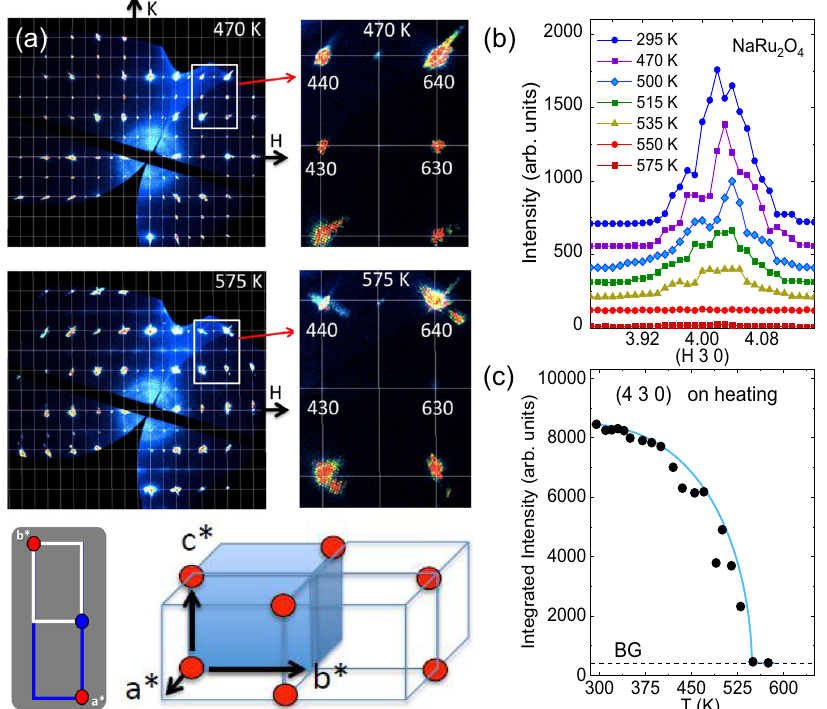
Fig. 5 Single-crystal x-ray diffraction (SC-XRD). a Reciprocal lattice maps of the SC-XRD data for NaRu 2 O 4 obtained at 470 and 575 K with the fi rst-order transition at T c = 535 K. b The line cut for various temperatures below and above the fi rst-order phase transition as extracted from the reciprocal space analysis. c Temperature dependence of the (4 3 0) super-lattice